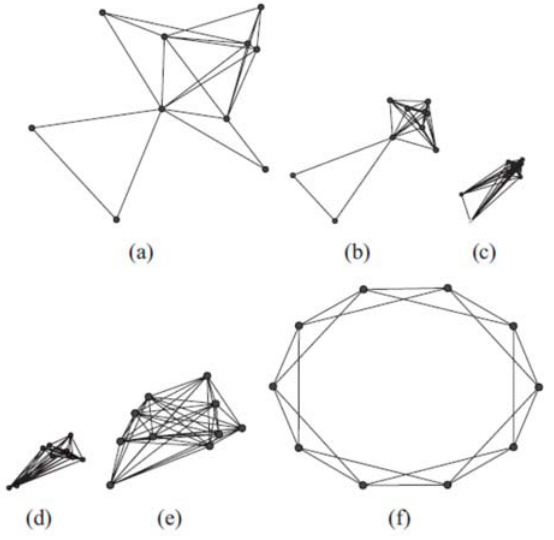
Figure 11. Rendezvous to Formation Control [19]. ( a – c ) Achieving rendezvous ( d – f ) Adjusting to desired formation.